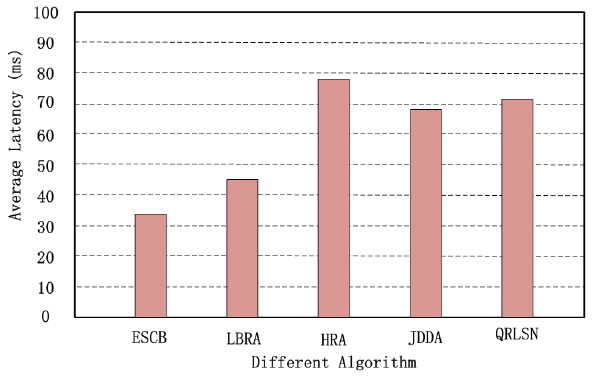
Figure 17. Latency performance comparison.